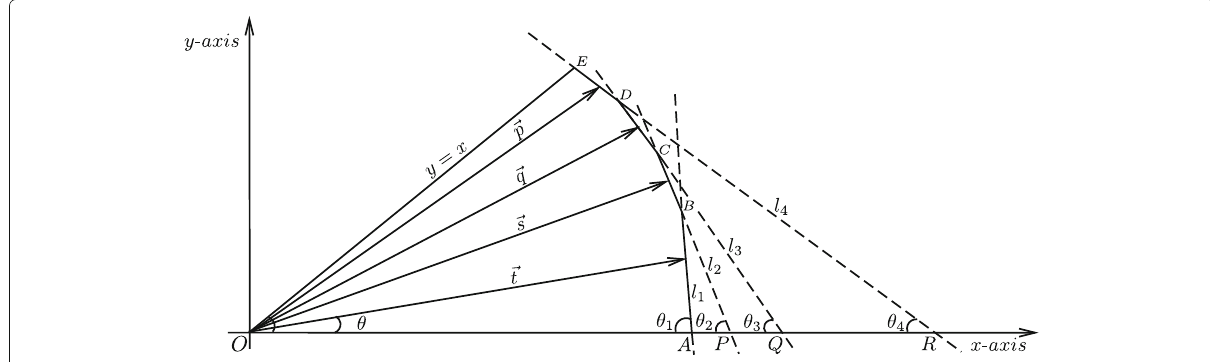
) , C ( 2 r ) , D ( 3 r ) , E ( r ) , ,0 ) , B ( 3 r , r , r , 2 r , r a d d c c e e b b